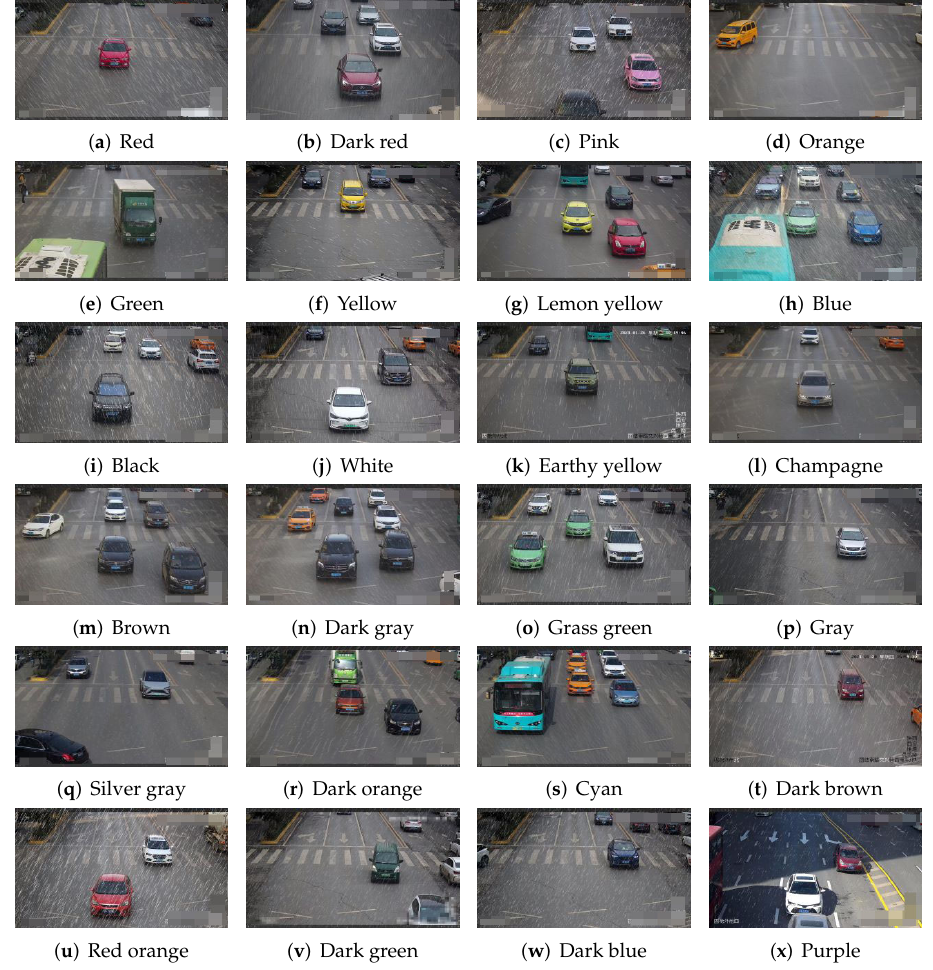
Figure 8. Illustrations of some samples from Rain Vehicle Color